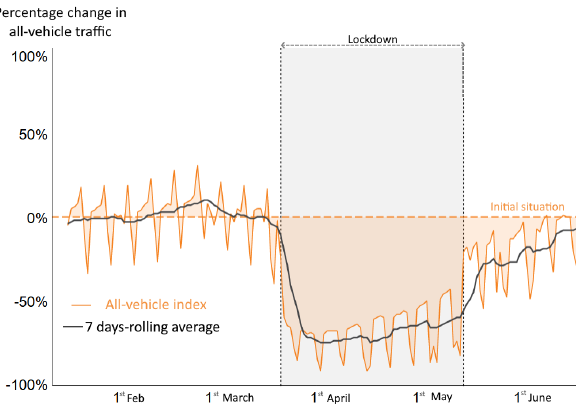
10 th 2020). It is generally observed that the reductions are smaller during the last weeks of